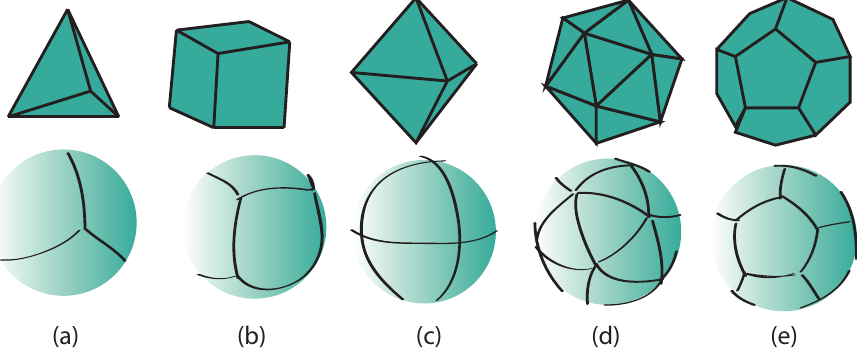
( Top ) ( a ) The tetrahedron, ( b ) cube, ( c ) octahedron, ( d ) icosahedron and ( e ) dodecahedron and ( bottom ) the corresponding spherical polyhedron of each.